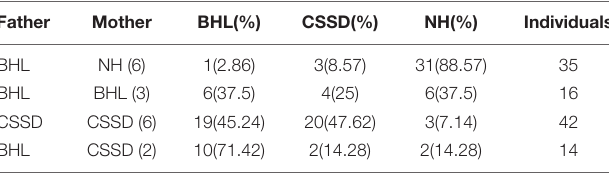
TABLE 2 | The phenotype distribution under different mating strategies in 4 th generation.